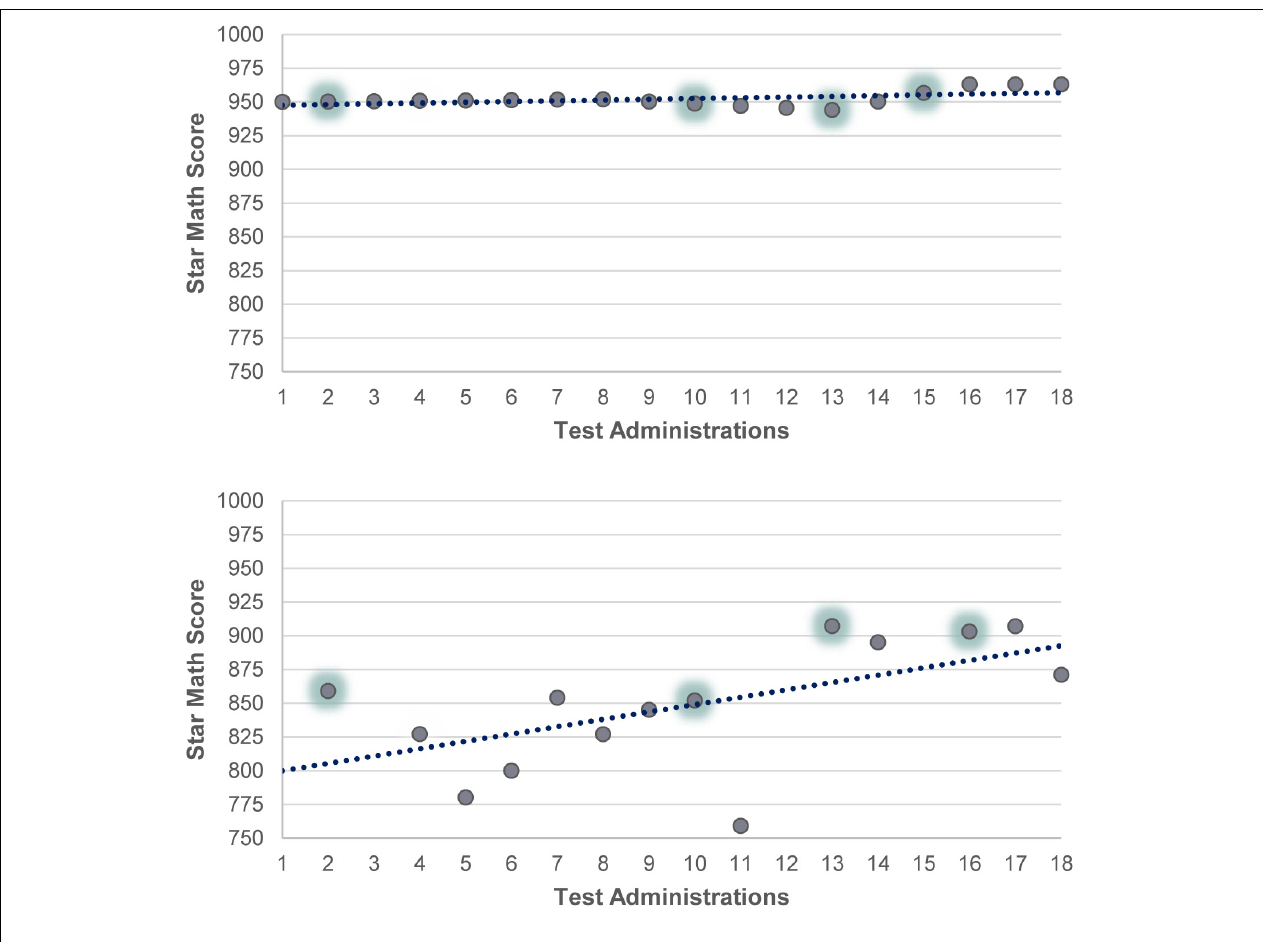
FIGURE 3 | Original and recommended test administrations for two students in grade 2.